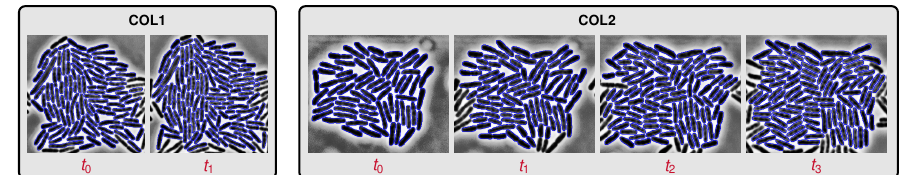
Figure 6. Segmentation results for experimental recordings of live cell colonies. We show two short image sequences extracts COL1 ( left ) and COL2 ( right ). The interframe duration is six minutes. The image sequence extract COL1 has only two successive image frames. The image sequence extract COL2 has four successive image frames. We are going to automatically compute four cell registrations, one for each pair of successive images in COL1 and COL2.